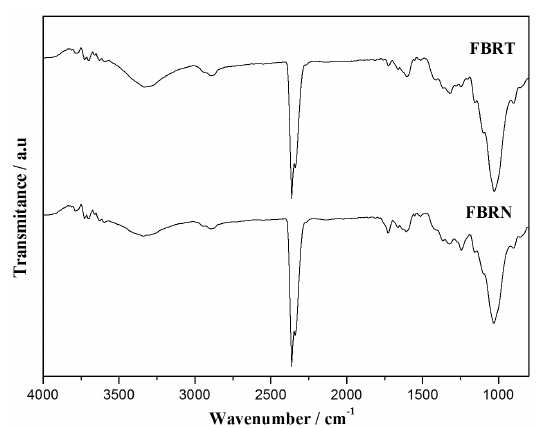
Figure 3. FTIR analysis of purple banana fibers in natura and treated.